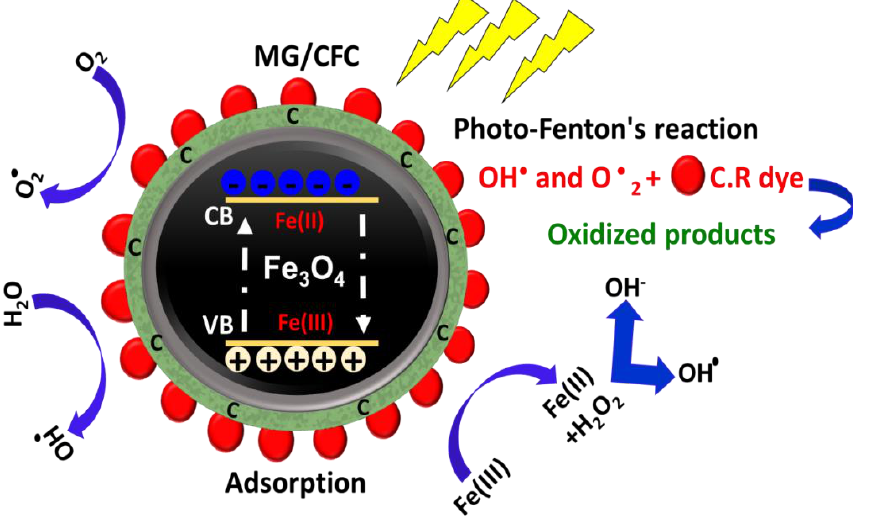
Figure 9. Schematic diagram for the suggested photocatalytic and photo-Fenton’s oxidation of C.R by MG/CFC.